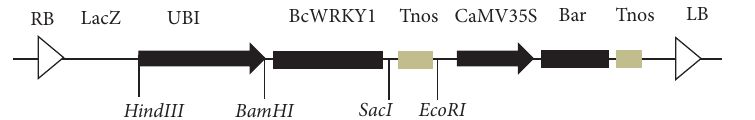
Figure1: Schematic oftheexpression vector p3300-Ubi- BcWRKY1 .RB,rightborder; LB,left border;UBI,ubiquitinpromoter;Tnos,nopaline synthaseterminator; BcWRKY1 , Boea crassifolia WRKY1 gene; Bar,Bialaphos resistanceselectable marker gene; CaMV35S , cauliflower mosaic virus 35S promoter. HindIII , BamHI , SacI , and EcoRI are restriction endonuclease recognition